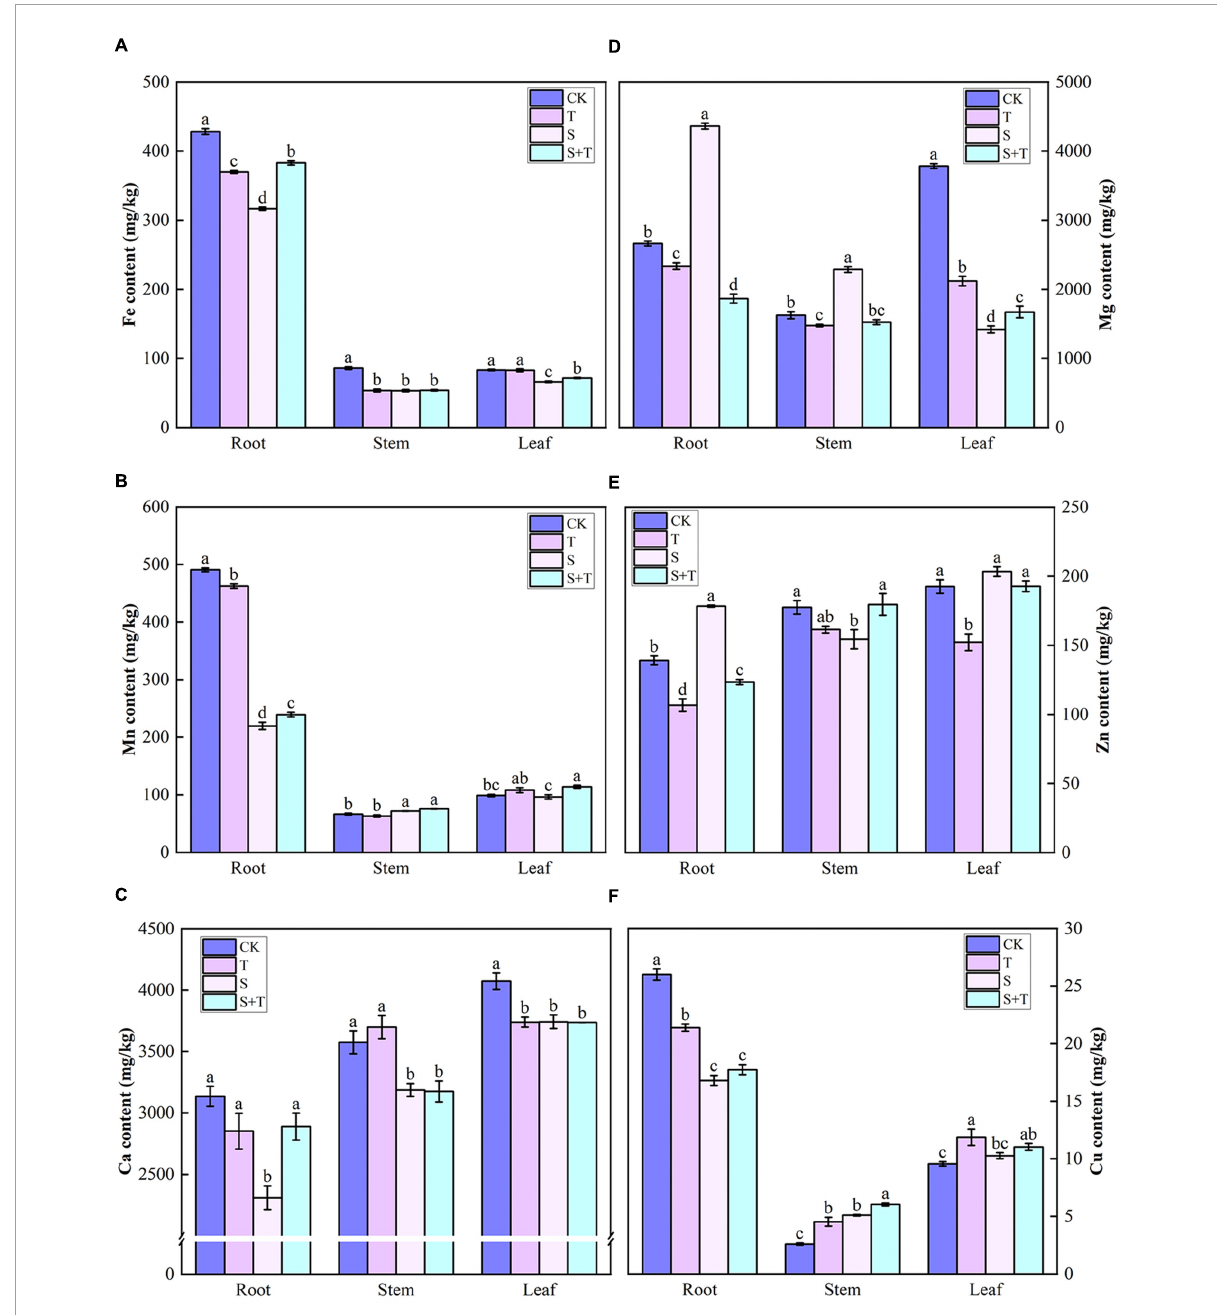
FIGURE8 Effects of Tre treatment on mineral ion content in tomato seedlings under salt stress for 5 days. (A) Fe content. (B) Mn content. (C) Ca content. (D) Mg content. (E) Zn content. (F) Cu content. The results showed the mean ± SE of three replicates, and the different letters denote the significant difference among treatments ( P < 0.05), according to Duncan’s multiple tests. CK, control; T, 10 mM Tre; S, 150 mM NaCl; S+T, 150 mM NaCl + 10 mM